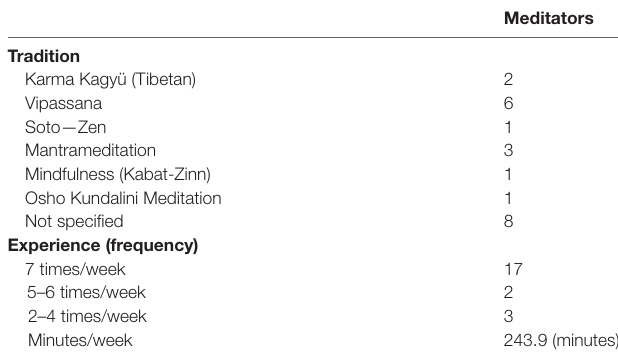
TABLE 1 | The characteristics of the meditation experience of the meditating